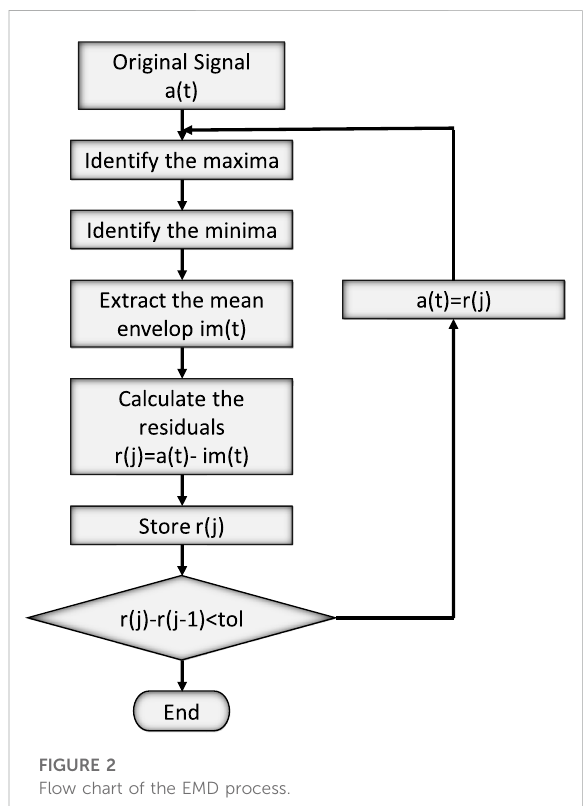
FIGURE 2 Flow chart of the EMD